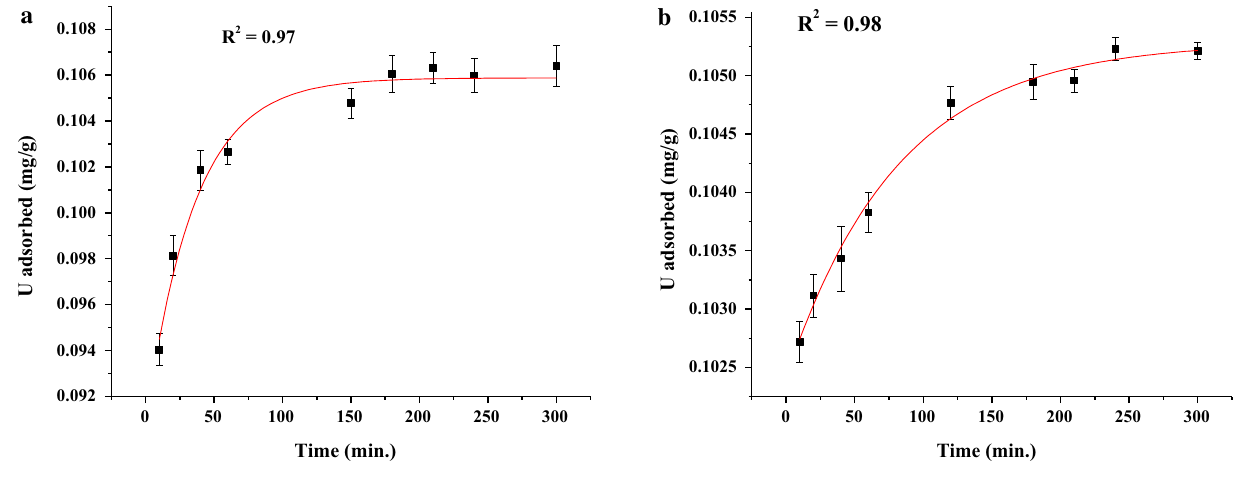
Fig. 2 Variation of U adsorption with respect to solid–liquid contact time for a FA and b